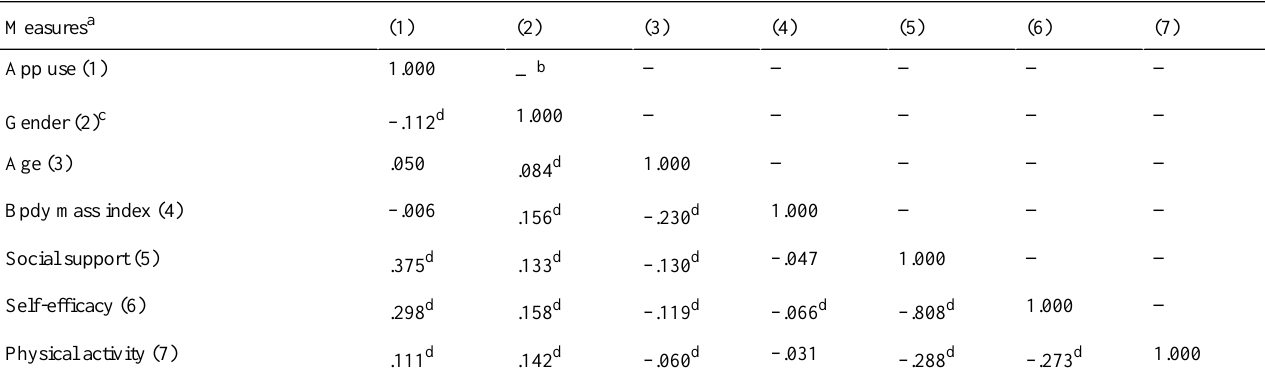
Table 3. Zero-order correlations between measures.